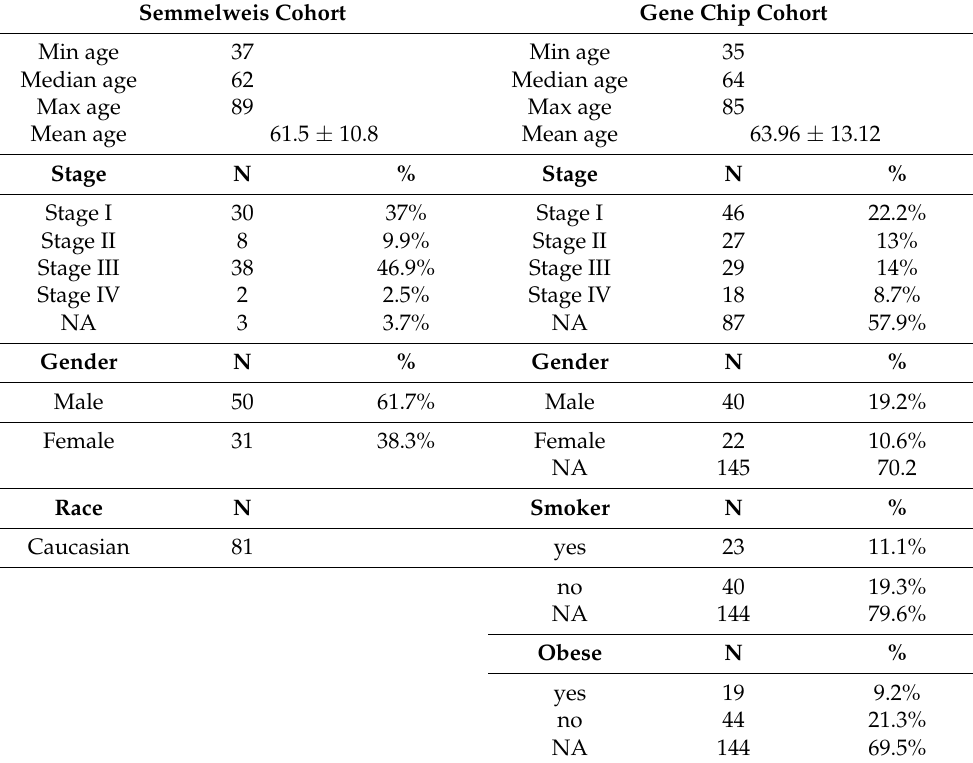
Table 1. Patient characteristics of the two datasets with normal and tumor tissues including the Semmelweis cohort ( n = 81 patients) used for MS and the gene chip cohort ( n = 207 patients) collected from NCBI